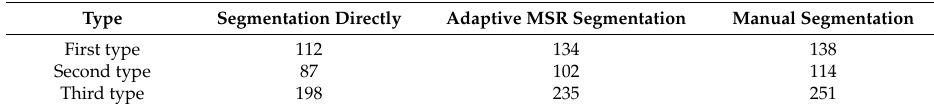
Table 2. The number of bubbles in three types of images.